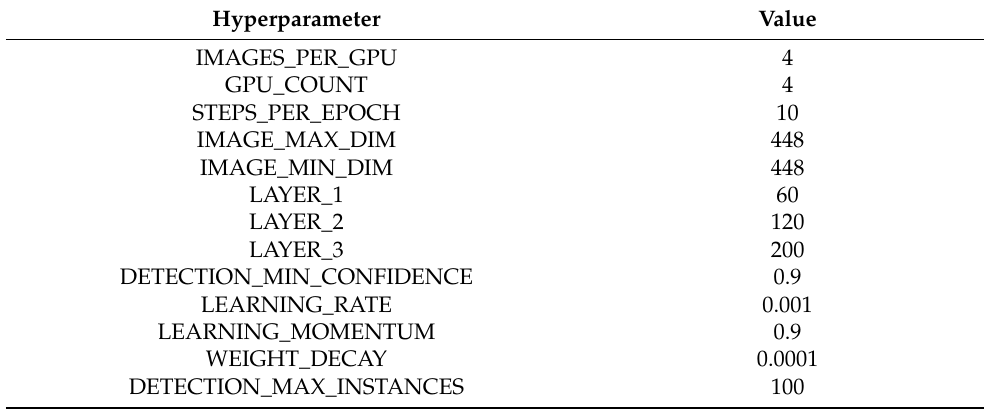
Table 1. Hyperparameters used in Mask R-CNN